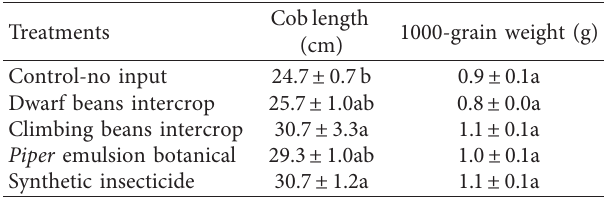
Figure 2: Impact of treatments on maize grain yield (mean ± SD). Values with different letters are significantly different ( P < 0 . 05). Table 3: Impact of treatments on the length of maize cobs and 1000-grain